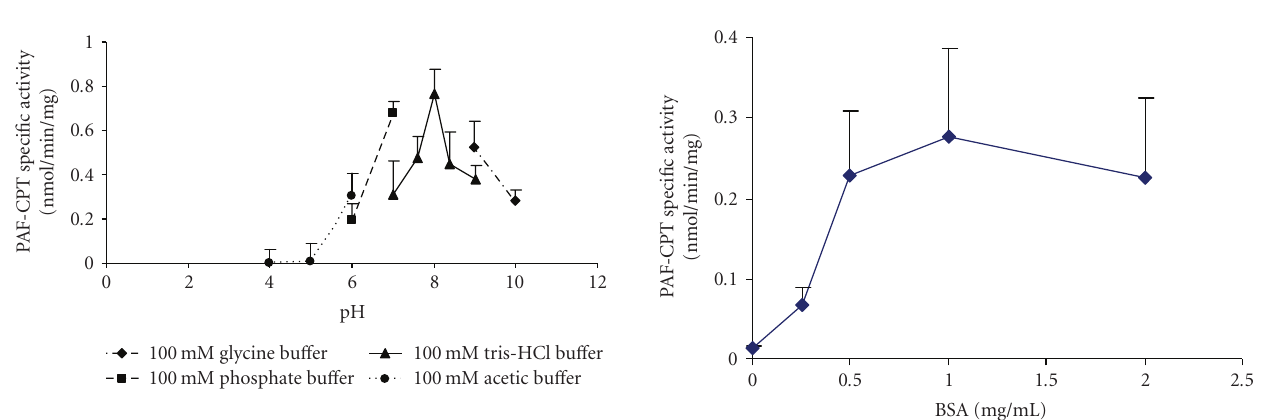
Figure 2: E ff ect of BSA concentration on PAF-CPT specific activ- ity of mesangial cells: microsomal fractions of HMC 0.05 mg/mL were incubated in the presence of di ff erent concentrations of BSA. Results are the average of two independent determinations using di ff erent enzyme preparations performing duplicate samples.